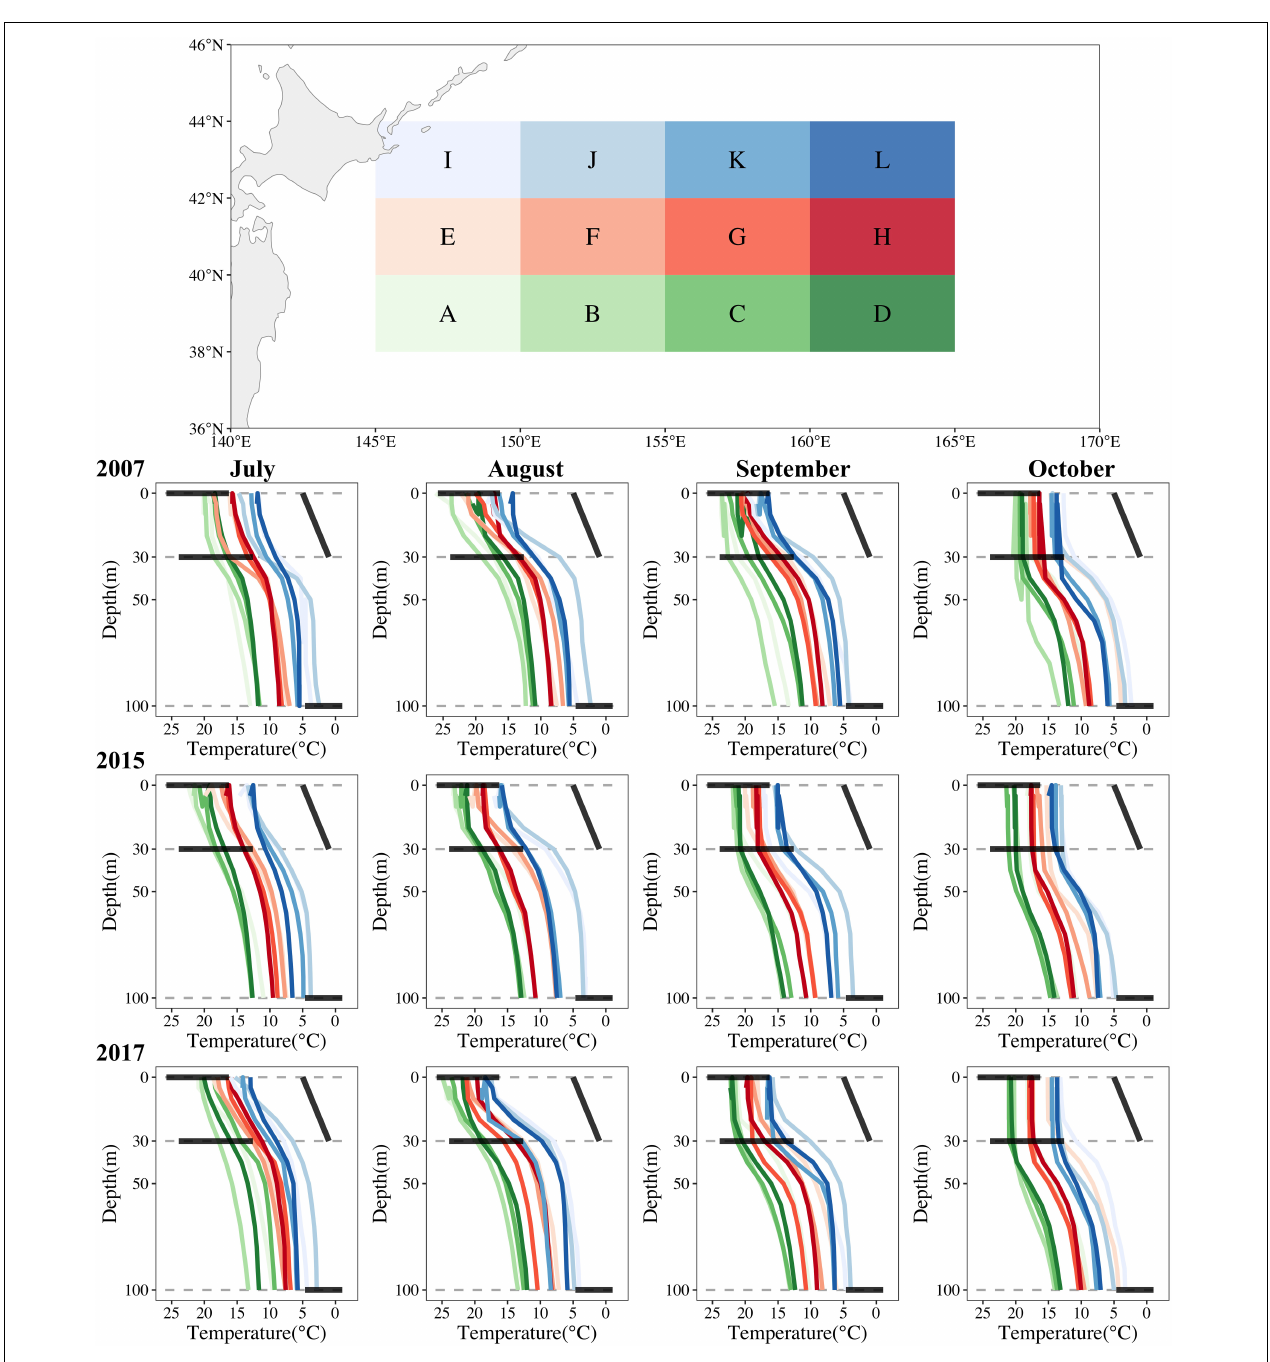
FIGURE 7 | The vertical profiles of water temperature on the O. bartramii fishing ground for July–October for three scenarios (La Niña year in 2007; El Niño year in 2015; normal year in 2017) in the Northwest Pacific Ocean. Three horizontal bold black lines represent the suitable ranges of T 0 , T 30 , T 100 , and the oblique bold black line represents the suitable water difference of D 0_30 in each